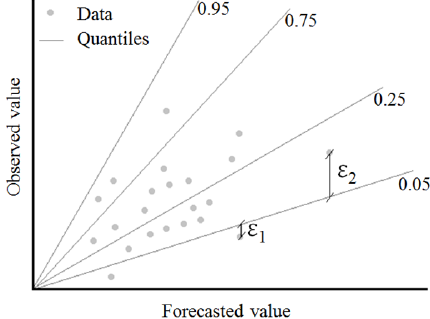
Figure 1. Quantile regression example scheme considering differ- ent